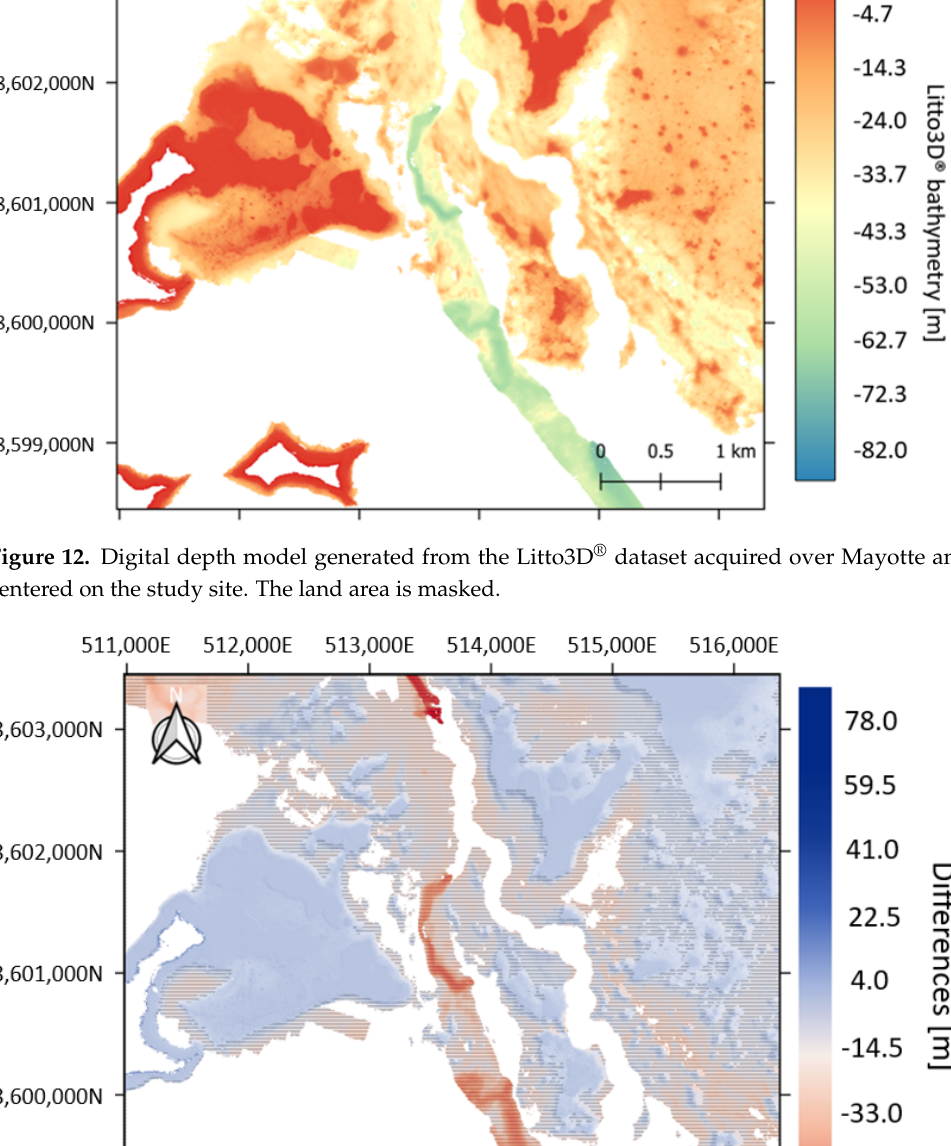
Figure 13. Map of the differences between the DDM derived from the Litto3D ® and the ICESat- 2/Pleiades-1 fusion.